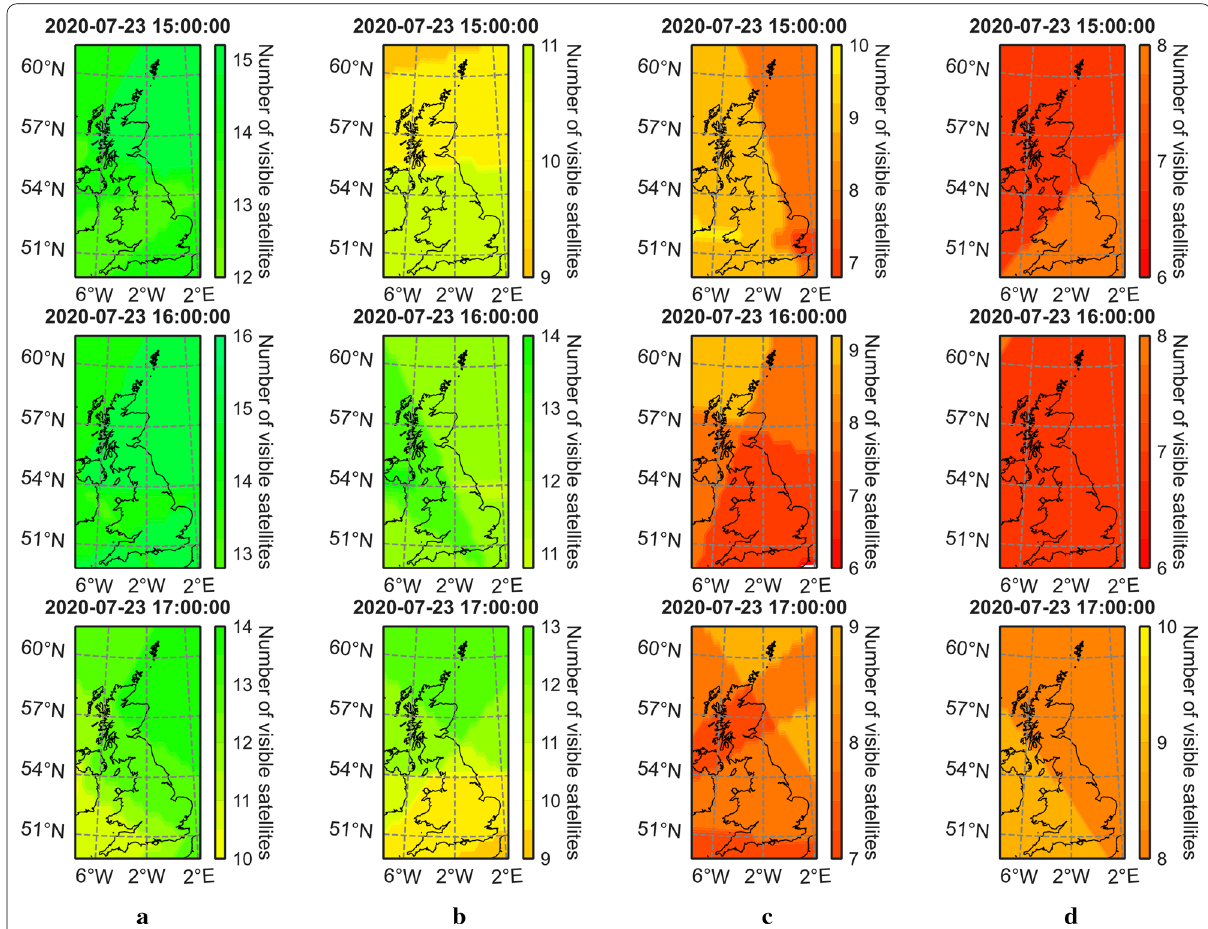
Fig. 3 The number of the visible satellites for a BDS, b GPS, c Galileo and d GLONASS at three moments in the UK territory